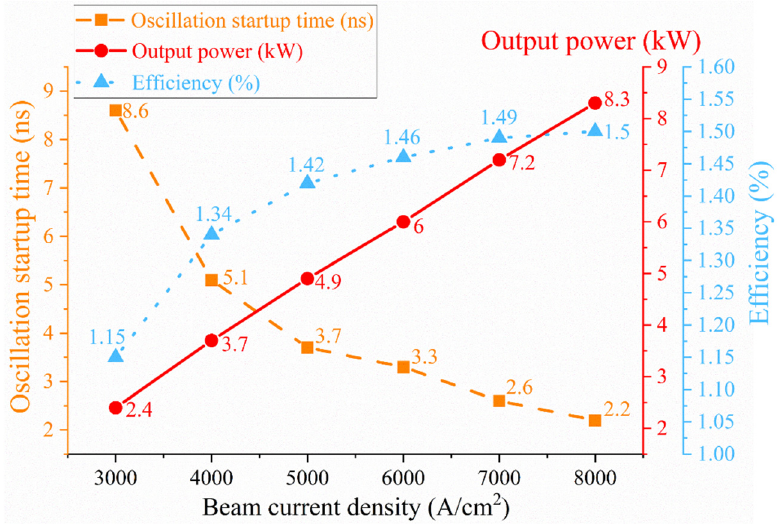
Figure 9. Oscillation startup time, output power, and efficiency are analyzed as a function of beam current density.